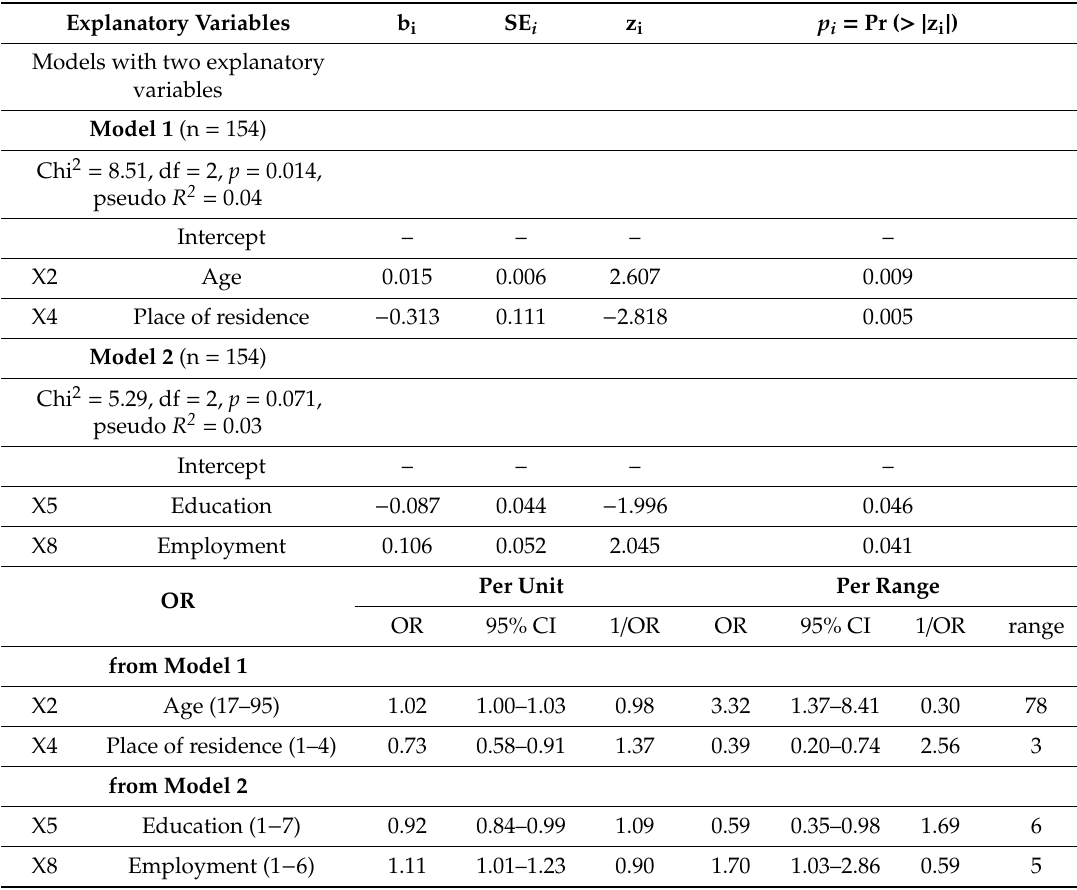
Table 7. Results of logistic regression analysis and the odds ratio in logistic regression model in caregivers. Explained variable: Emotional exhaustion (0—smaller, 1—bigger emotional exhaustion). Explanatory Variables b i SE